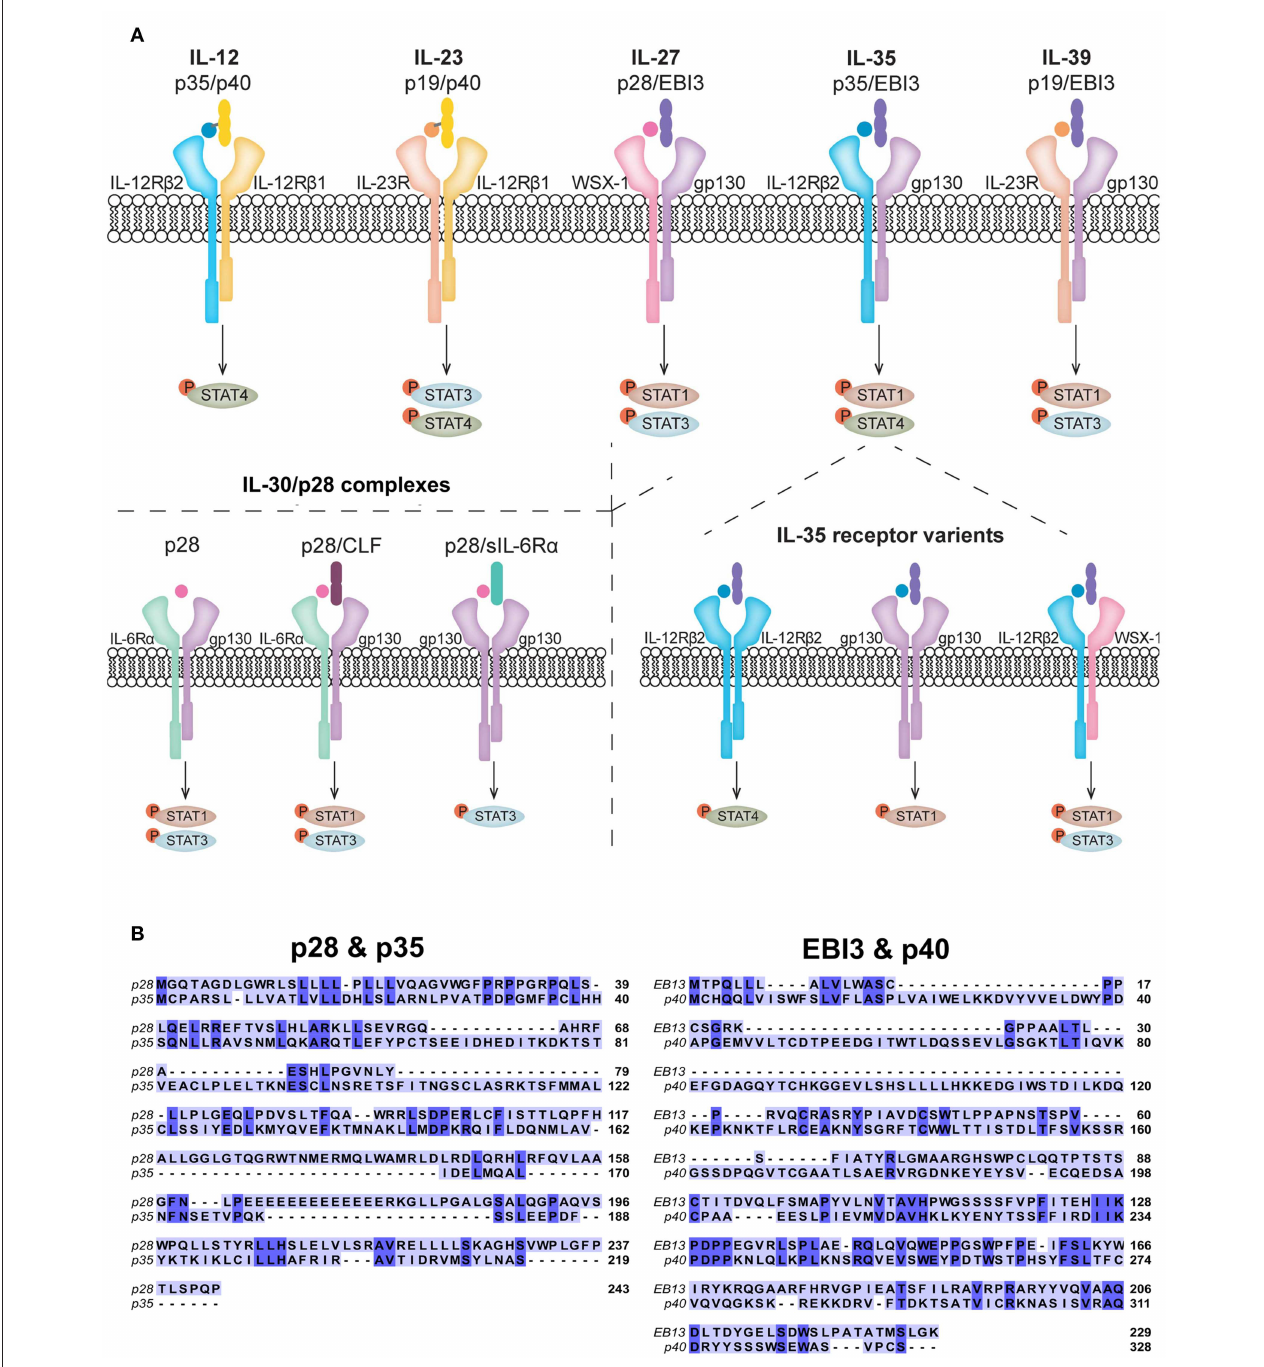
FIGURE 1 | Receptor composition of IL-12 family members and related cytokines. (A) The IL-12 family members are heterodimeric in composition and signal via heterodimeric receptors. IL-27, composed of p28 and EBI3, shares common subunits with IL-35 (p35 and EBI3) and IL-39 (p19 and EBI3). The p28 subunit has also been shown to have biological activity in the absence of EBI3, known as IL-30. In addition to subunit sharing with IL-27 and IL-39, IL-35 shares the p35 subunit with IL-12. p28 is also known to form complexes with CLF and sIL-6R α . Signaling of all IL-12 family members, IL-30, and other known p28 complexes, predominantly activate the JAK/STAT pathway. Each cytokine preferentially activates specific STATs to achieve its functional role, although other phosphorylated STATs have been observed. (B) Amino acid sequence overlays for human p28 (accession number: NP_663634.2) with p35 (accession number: NP_000873.2) and EBI3 (accession number: NP_005746.2) with p40 (accession number: NP_002178.2) were aligned using the T-COFFEE-espresso program (11). Shared amino acids are indicated by dark blue shading and homology between p28 and p35 was calculated to be 64% (44 of 169) and between EBI3 and p40 was calculated to be 33% (59 of 177).